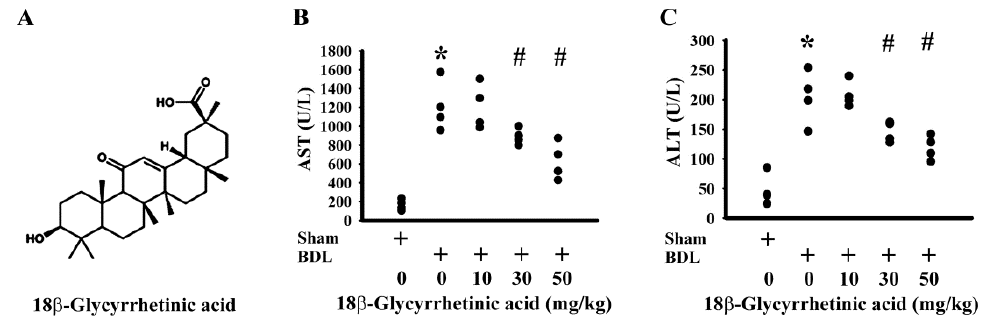
Figure 1. 18 β -Glycyrrhetinic acid decreased serum biochemical parameters in the test study. Chemical structure of 18 β -Glycyrrhetinic acid is shown ( A ). Serum levels of AST ( B ) and ALT ( C ) activity were measured. * p < 0.05 vs. the sham vehicle group and # p < 0.05 vs. the BDL vehicle group, n = 4.